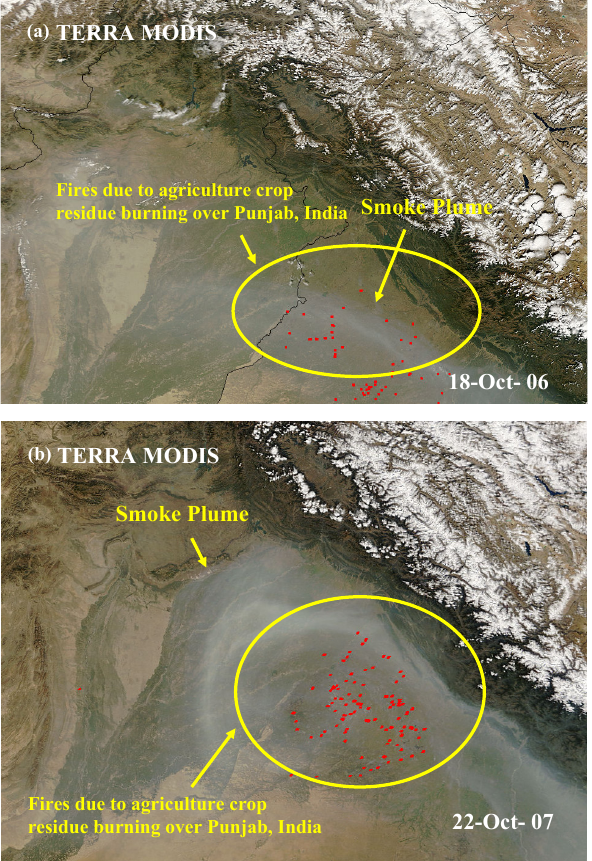
Fig. 6. Terra MODIS true color composite of study area showing smoke due to crop residue burning and fires in red color on 18 Oc- tober 2006 and 22 October 2007.